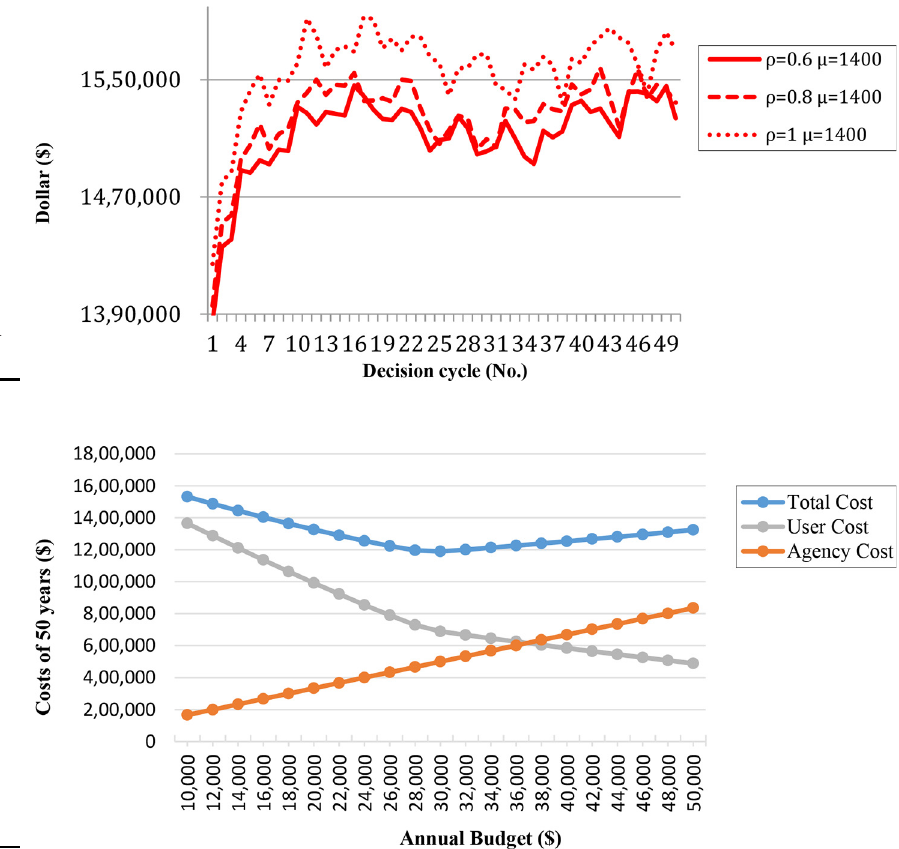
Figure 7. Sensitive analysis results of annual budget levels and optimal